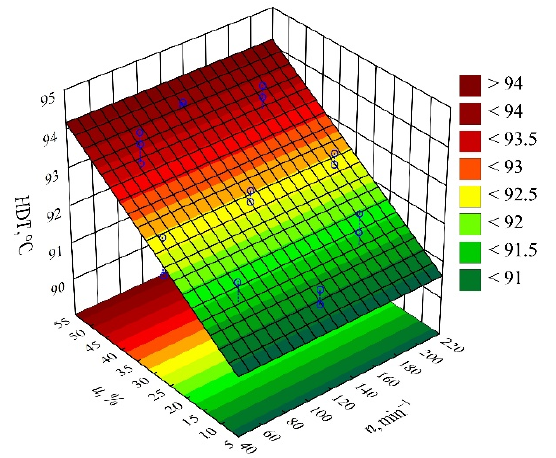
Figure 13. Response surface plot for the heat deflection temperature HDT versus wheat bran content u and screw speed n .